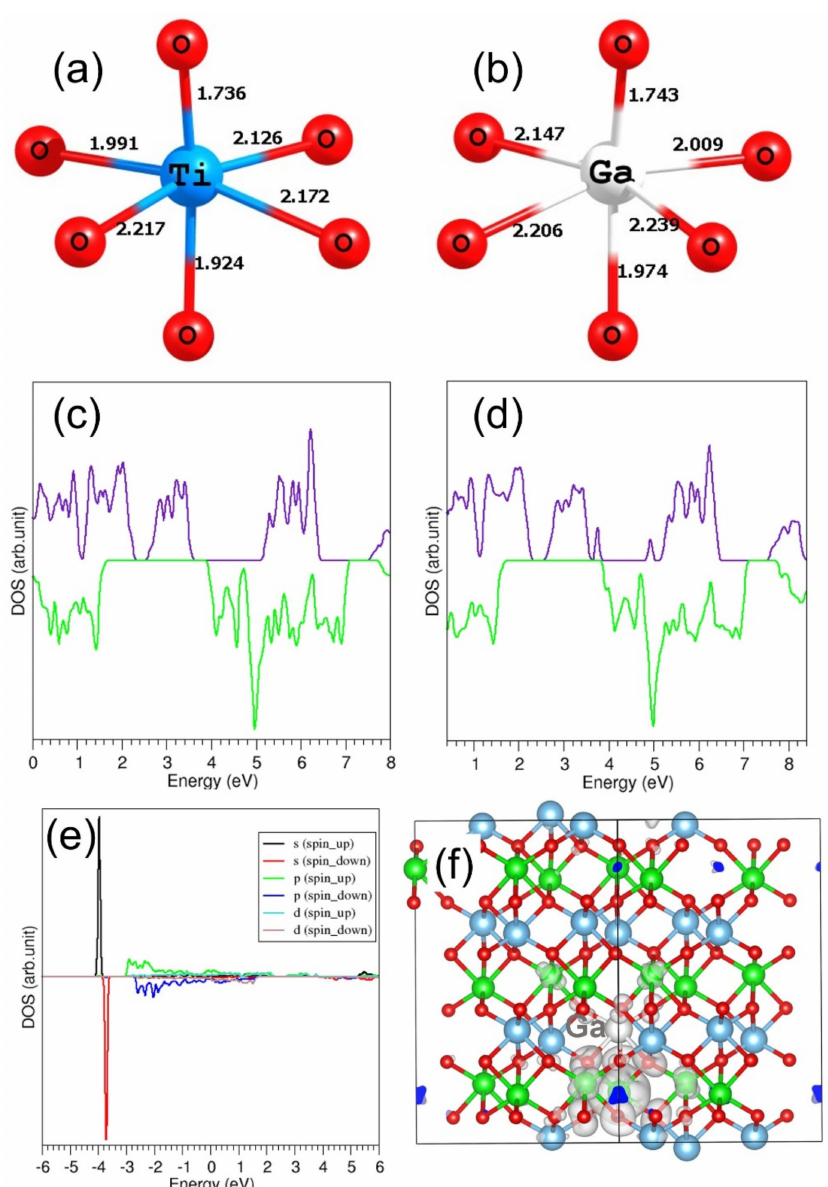
Figure 9. ( a ) TiO 6 octahedral unit showing bond lengths in the relaxed un-doped FeTiO 3 , ( b ) GaO 6 unit in the configuration of Ga 3 + doped at the Ti site, ( c ) total density of states (DOS) of FeTiO 3 , ( d ) total DOS of Ga-doped FeTiO 3 , ( e ) atomic DOS of Ga, and ( f ) constant charge density plot associated with the electron